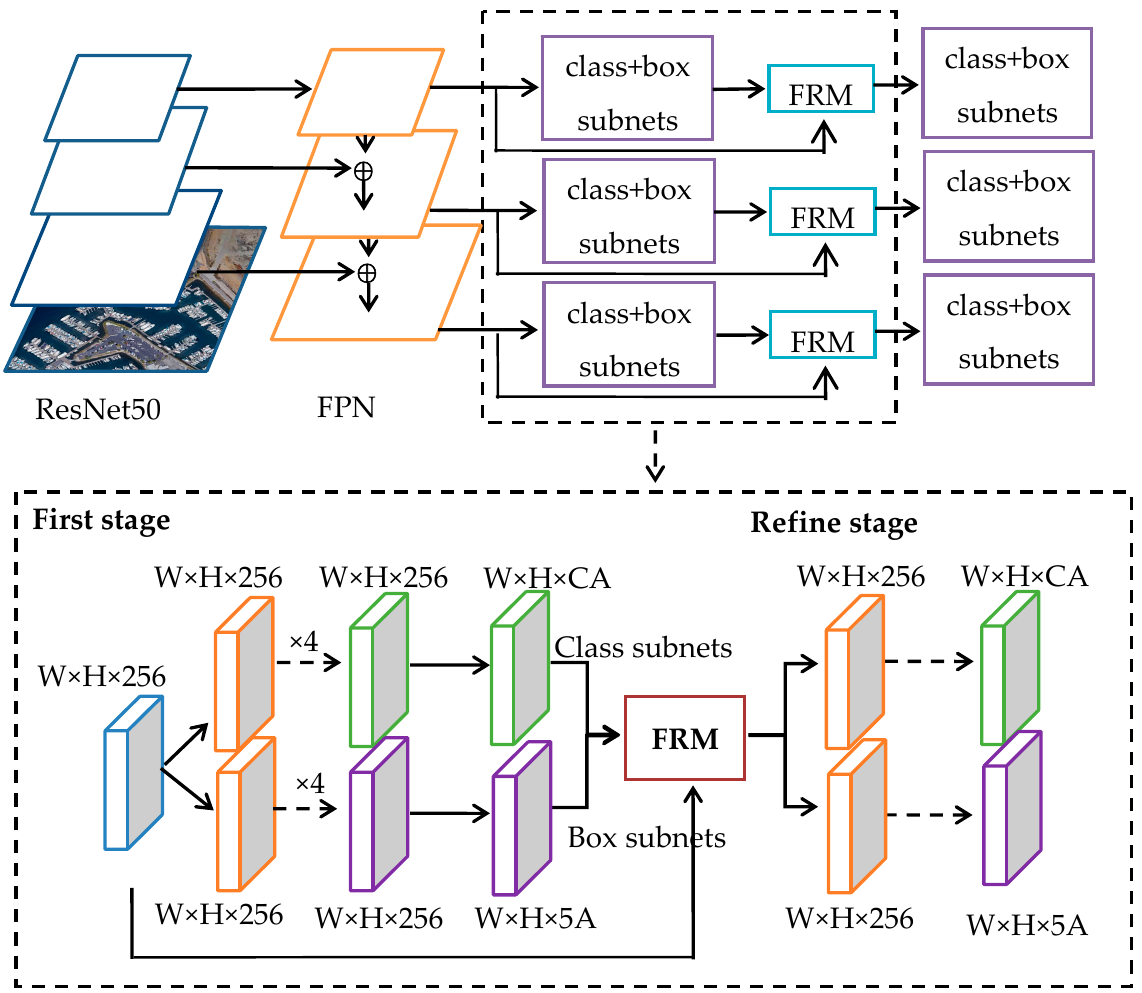
Figure 4. R 3 Det model structure.